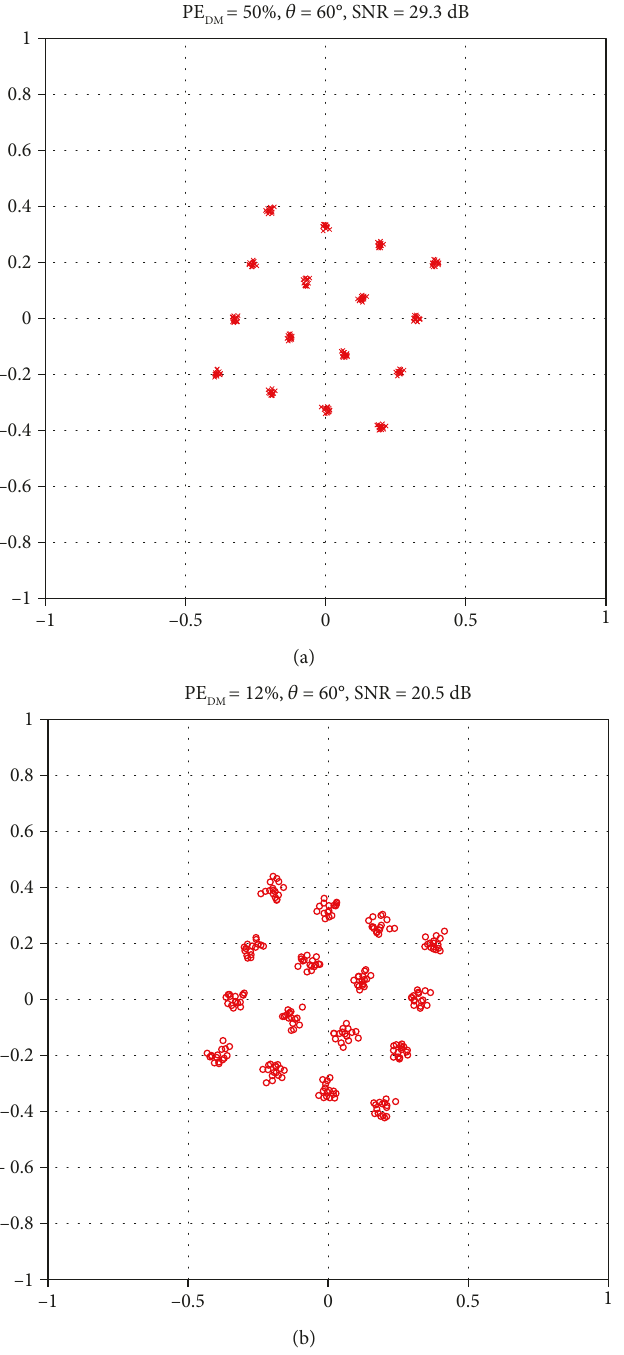
Figure 10: DDM 16-QAM modulation transmitted at the secure direction 60 ° using real components, coaxial cables and (12) to compute S 21 mn in the vector modulators; AEP measurement did not consider coaxial cables. (a)